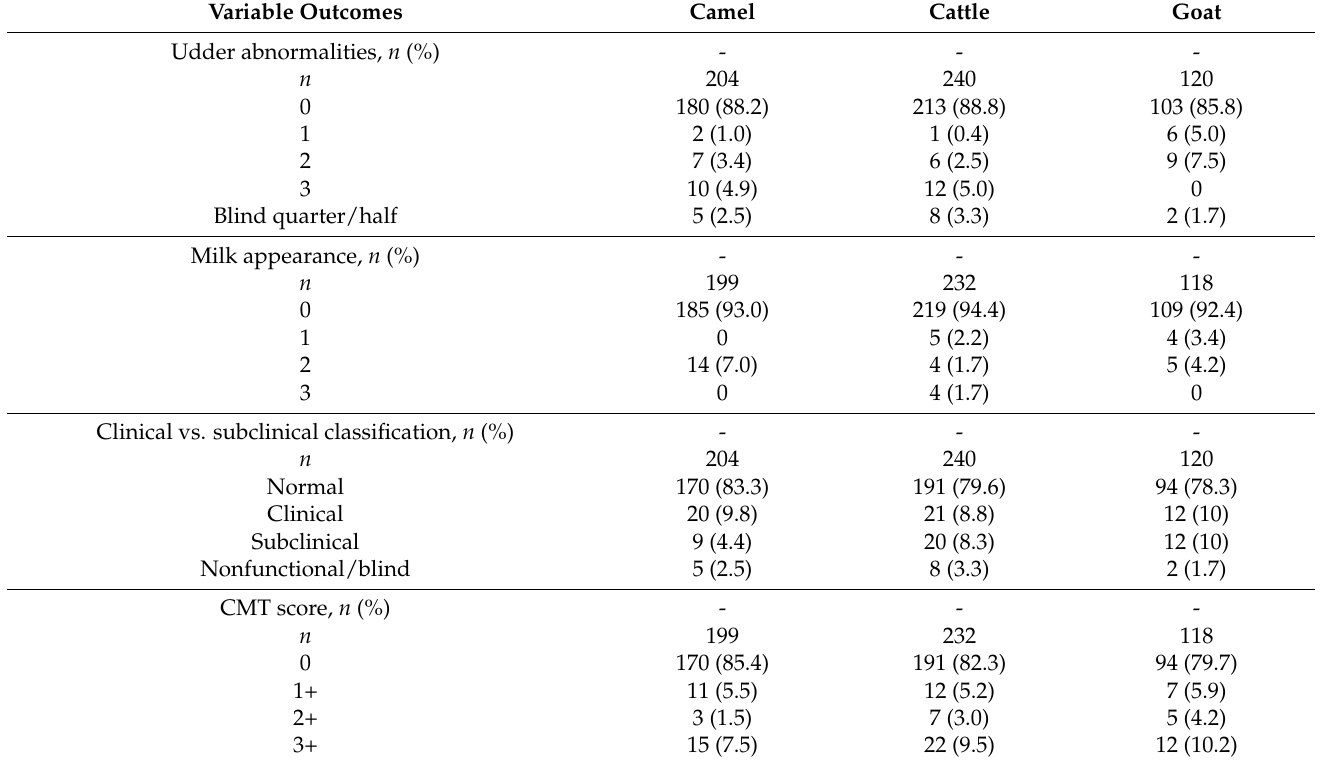
Accordingly, 9% and 10% of the udder quarters in cows and camels, respectively, and 10% of the udder halves in goats had clinical mastitis. Subclinical mastitis was observed in 8.6% and 4.5% of the udder quarters in cows and camels, respectively, and in 10% of the udder halves in goats (Table 3). In camels, the prevalence of udder abnormality ( p = 0.033) and mastitis ( p = 0.013) were significantly higher in late lactation than in early lactation. The prevalence of mastitis tended to increase ( p = 0.028) with parity in camels (Table 4). In cattle, the prevalence of mastitis was significantly ( p = 0.034) higher in the Dugda Dawa district compared with the Bule Hora district (Table 5). In goats, the prevalence of udder and milk abnormalities, overall mastitis prevalence, and clinical and subclinical mastitis were not affected by stage of lactation, district, and parity (Table 6). The prevalence of mastitis in dairy cows, camels, and goats was 33.3%, 26.3%, and 25%, respectively. In dairy cattle, the cow- and quarter-level prevalence was 33.3% and 17.1%, respectively. Cow-level prevalence of clinical and subclinical mastitis constituted 15% and 18.3%, respectively. The overall prevalence of mastitis in dairy camels was 29.4% and 14.2% at the animal and quarter level, respectively. Of the 29.4%, clinical and subclinical mastitis constituted 9.8% and 19.6%, respectively. The prevalence of mastitis in goats was 25%, which comprised 10% and 15% clinical and subclinical mastitis, respectively. Table 2. Distribution of variable outcomes observed among the udder quarters and udder halves. Variable Outcomes Camel Cattle Goat Udder abnormalities, n (%)